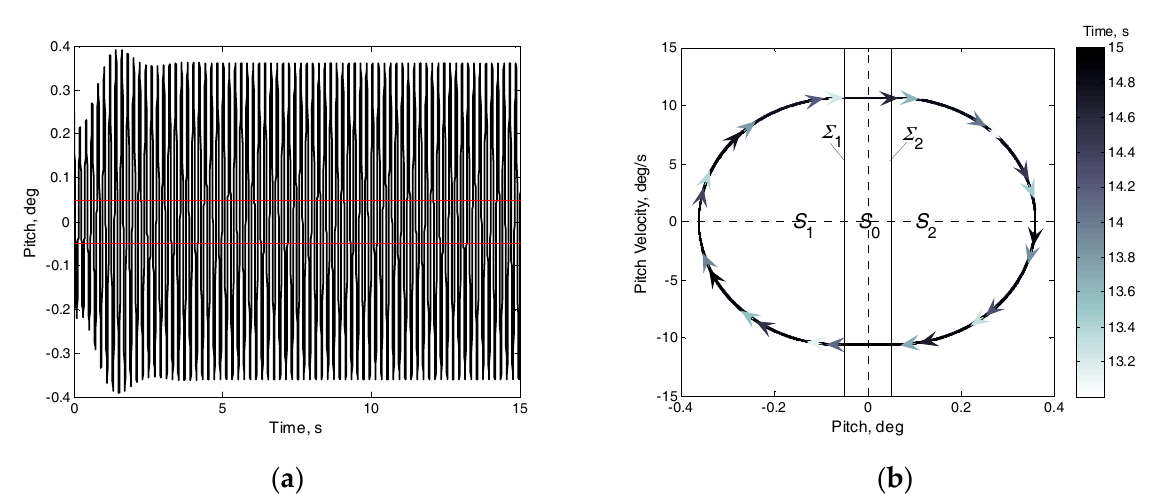
Figure 13. A three-domain LCO (3-D LCO) emerges when the flow velocity is 20 m/s and the initial non-dimensional pitch angle is 5.00, where the response of the freeplay state is presented by ( a ) a time history of 0–15 s and ( b ) a phase trajectory of 13–15 s.